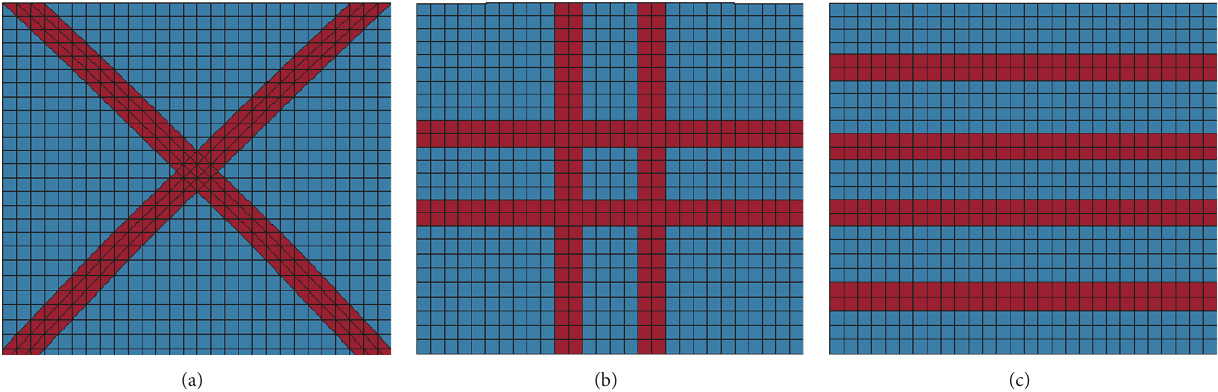
Figure 8: Fiber reinforcement arrangements: (a) model 1, (b) model 2, and (c) model